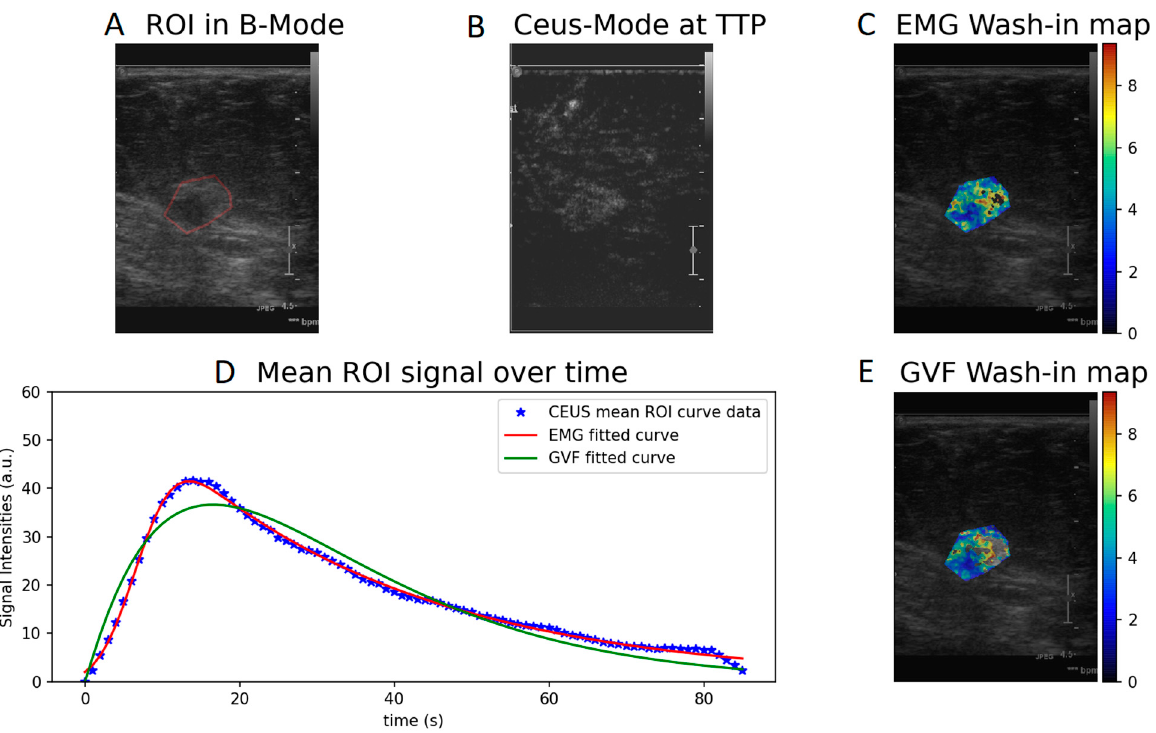
Figure 2. Wash-in parametric map calculated with EMG ( C ) and GVF ( E ) of a cancer patient. ( A ) ROI in B-mode, ( B ) CEUS mode at time to peak, and ( D ) EMG and GVF fitted to the mean ROI signal over time.